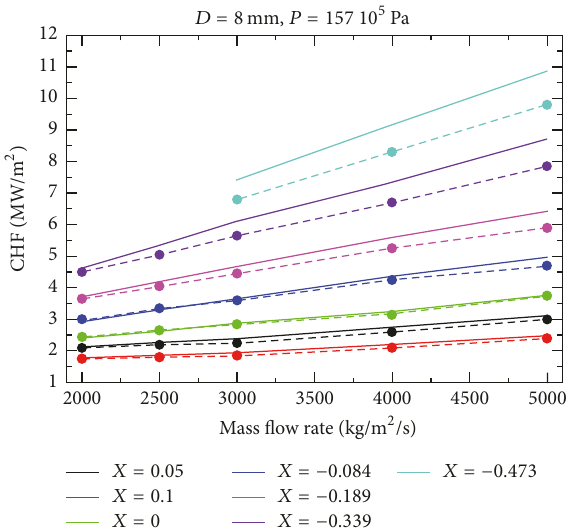
Figure 46: CHF prediction for different pressure values. Experi- mental values are represented by